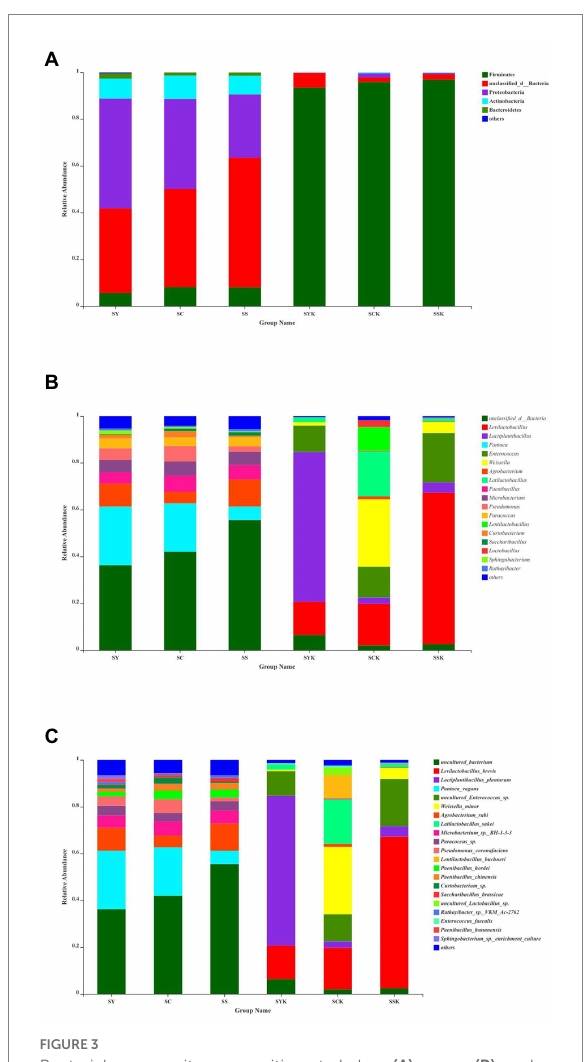
FIGURE 3 Bacterial community composition at phylum (A) , genus (B) , and species (C) level in fresh materials and ryegrass silage by SMRT. SY, Fresh materials at booting stage; SC, Fresh materials at initial flowering; SS, Fresh materials at full flowering; SYK, Silage samples at booting stage; SCK, Silage samples at initial flowering; SSK, Silage samples at full flowering.